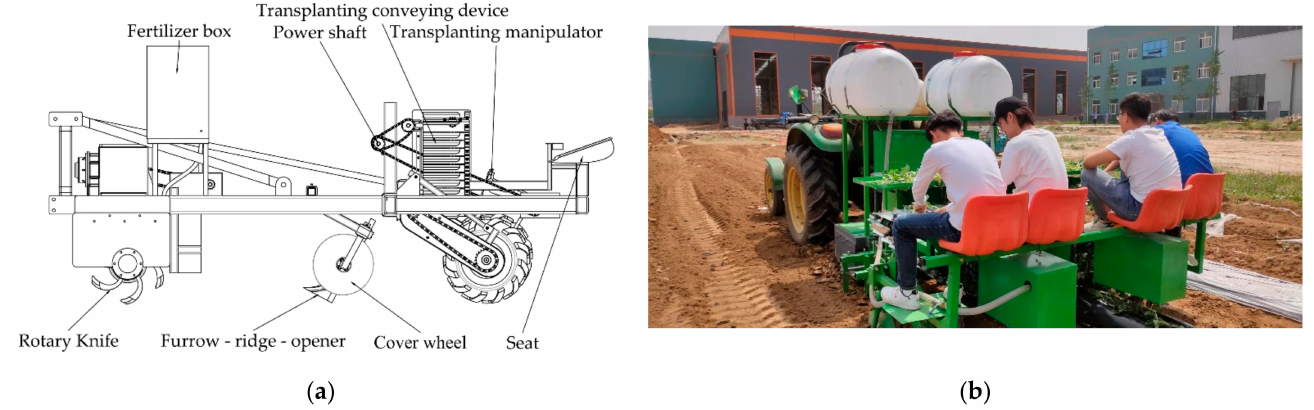
Figure 10. Transplanting manipulator and transplanting conveying device of sweet potato transplant- ing machine. ( a ) Diagram of the structure, ( b ) photo of a real machine.